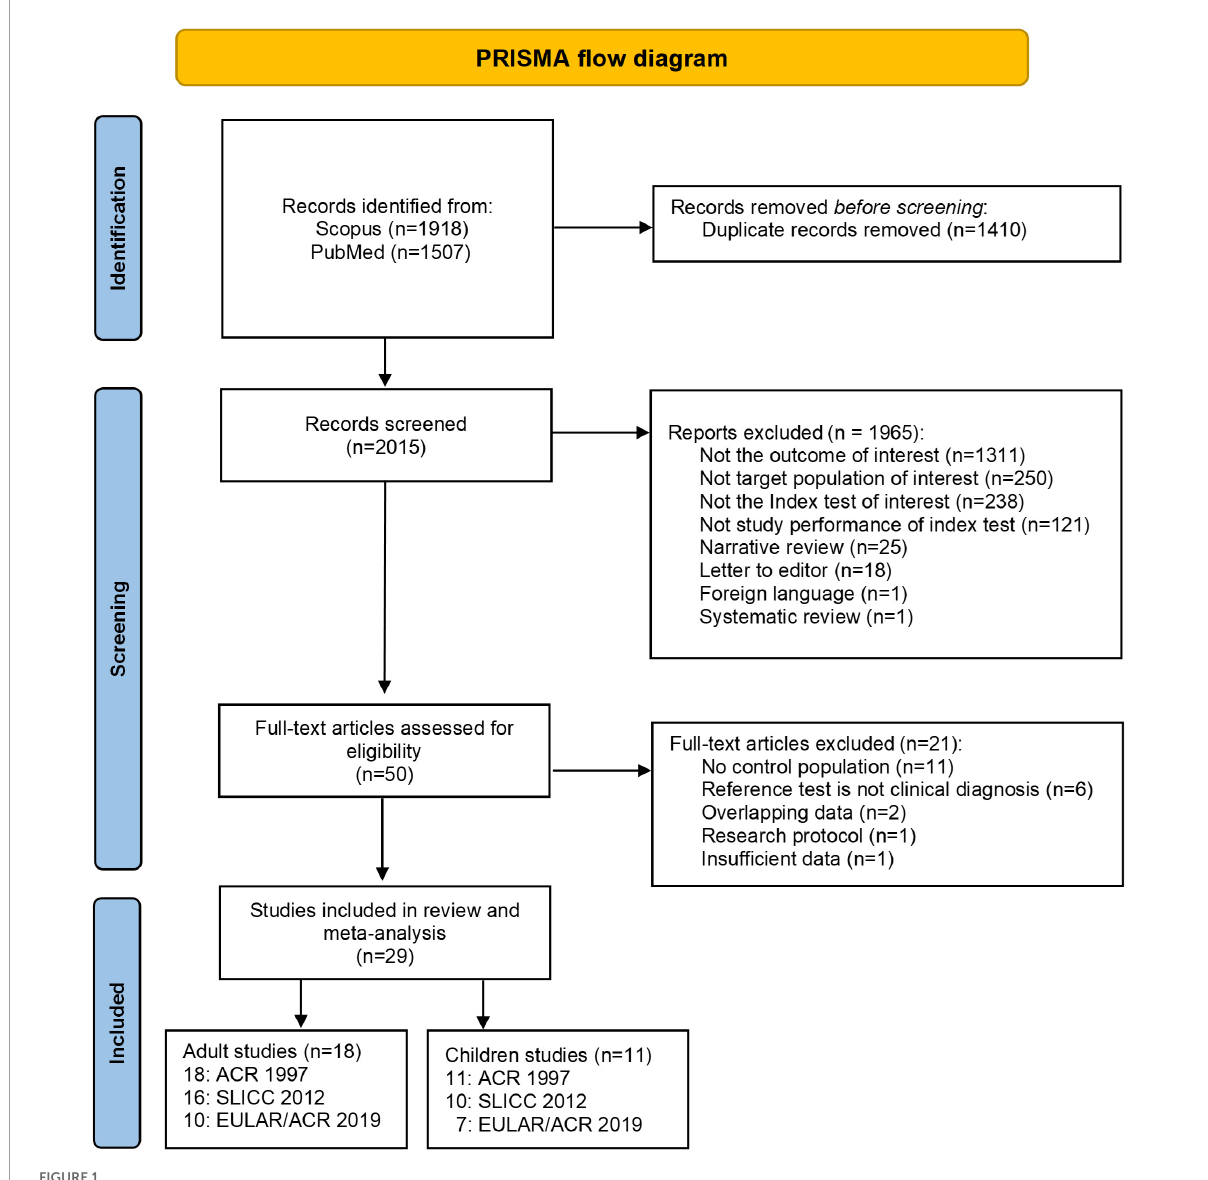
FIGURE1 A PRISMA flow diagram summarizing the study selection process.